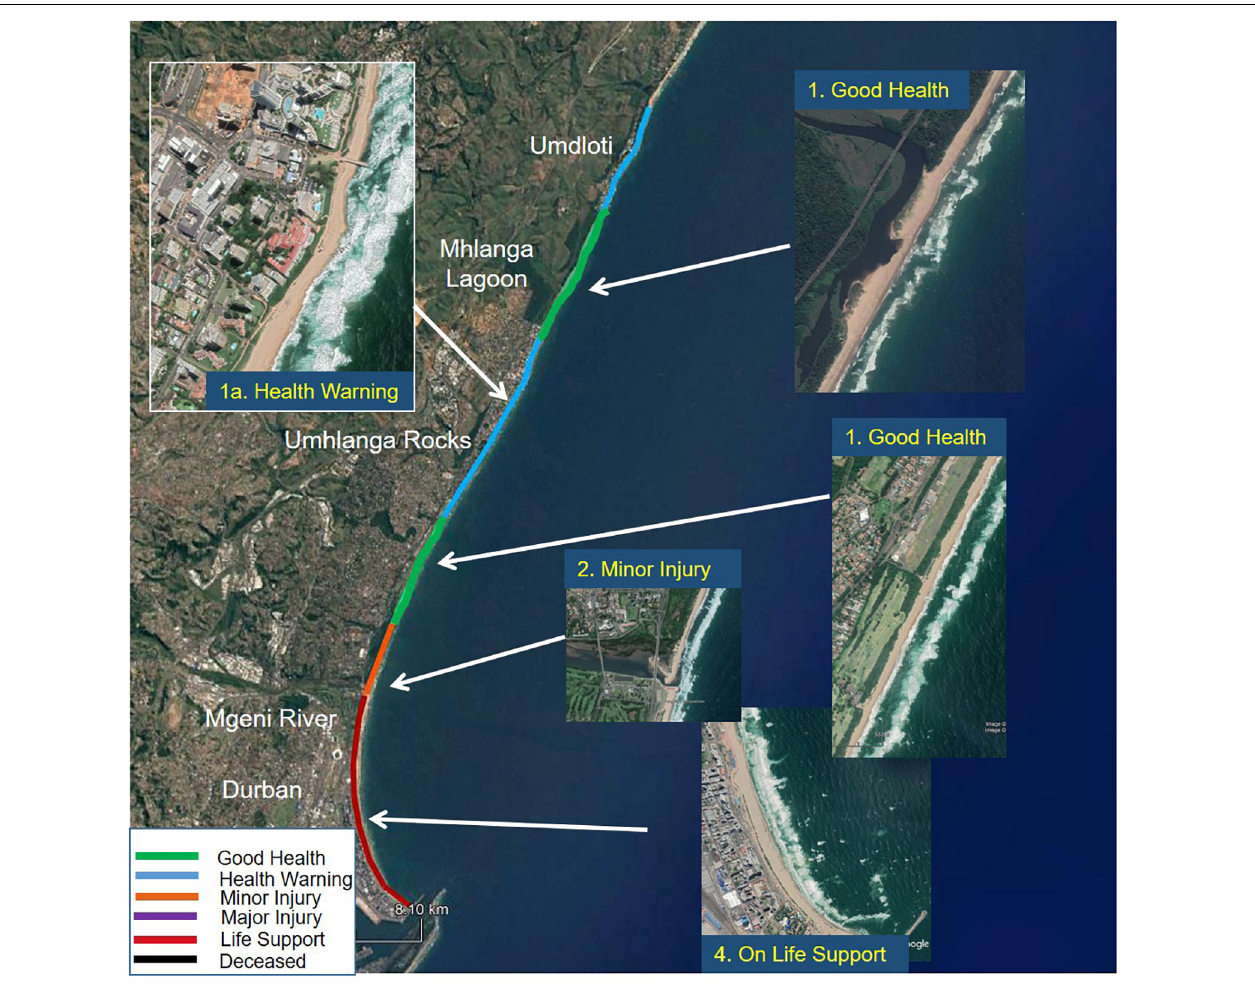
FIGURE 1 | Shoreline Health assessment of a section of the KwaZulu – Natal Coast of South Africa. For description see text. Main image and insets from Google Earth, Map data: SIO, NOAA, U.S. Navy, GEBCO, and AFRIGIS. Data (Insets) 2019 Digitalglobe.